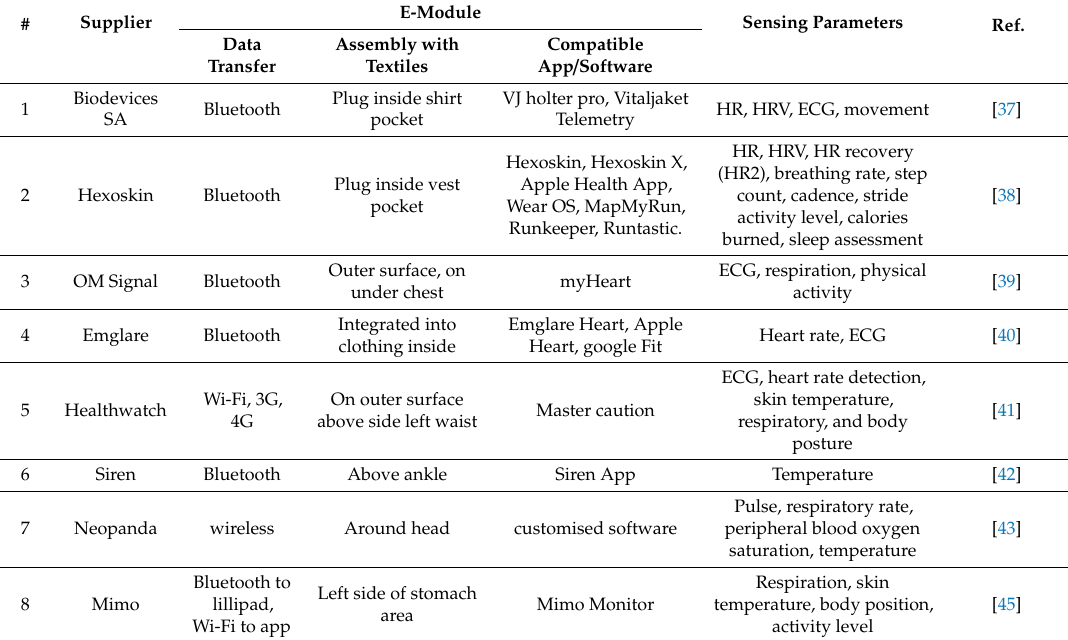
Table 3. Features of the electronics modules of available SeCSs for health monitoring. sEMG, surface electromyography; HR, heart rate; HRV, heart rate